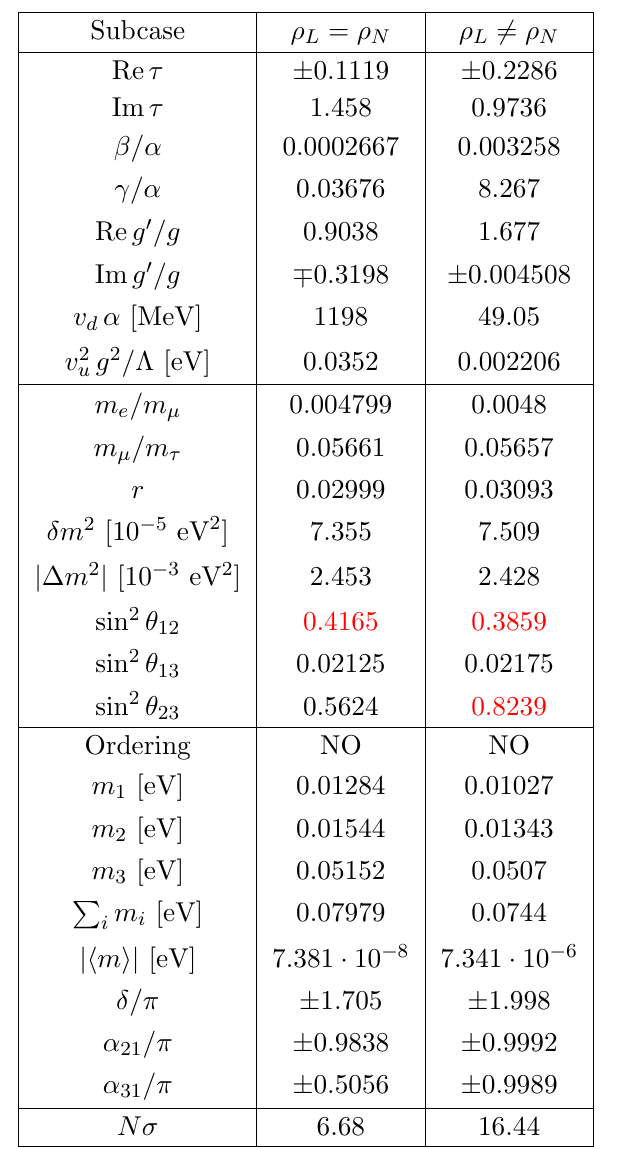
Table 6. Best (cid:12)t values of the parameters and observables in the models with ( k (cid:3) ; k g ) = (2 ; 2).